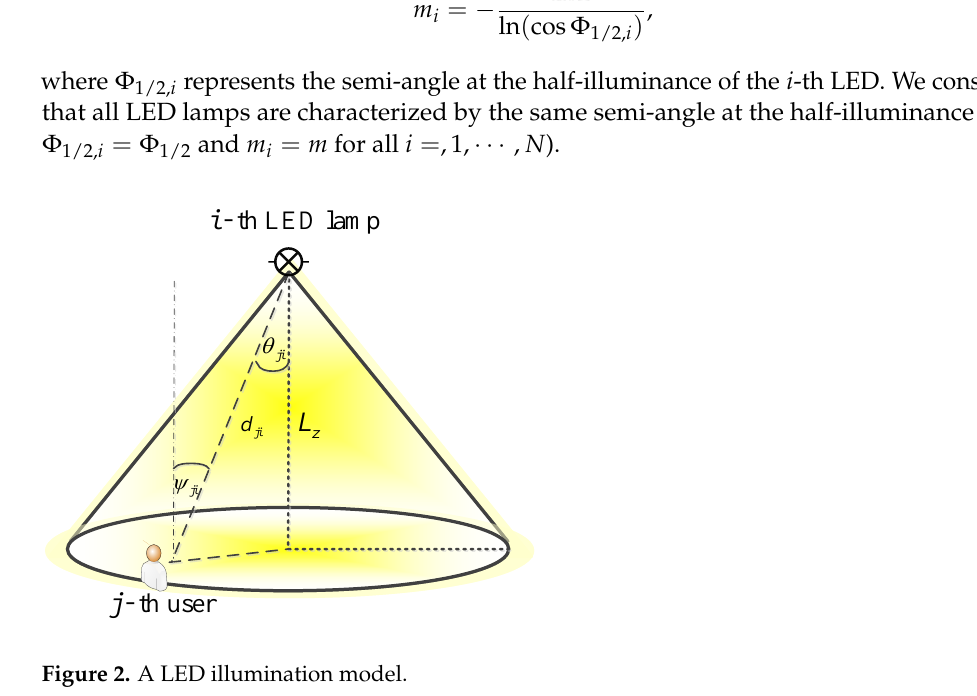
Figure 2. A LED illumination